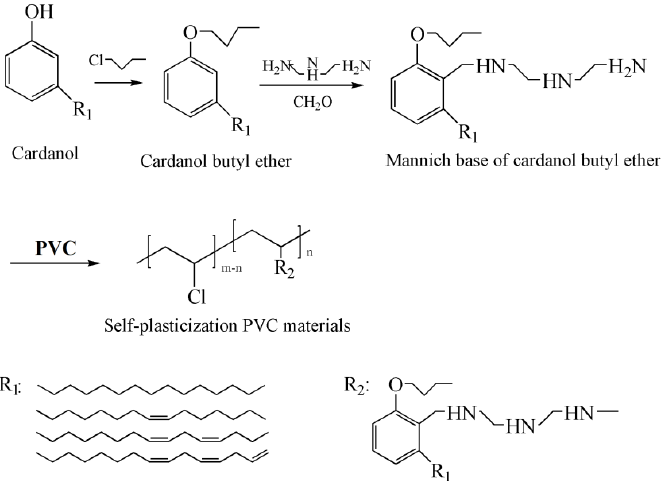
Figure 25. Synthesis of self-plasticization PVC via substitution reaction with minnich base of cardanol